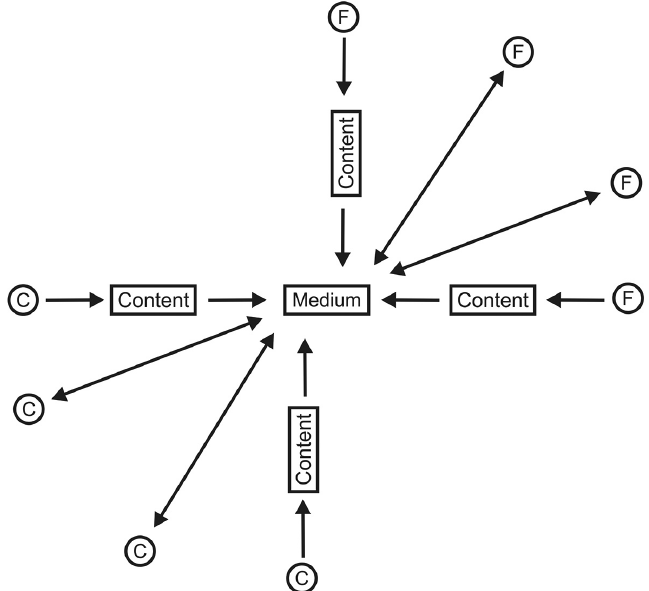
Figure 3. Model of marketing communications in a hypermedia computer-mediated environments (source: Hoffman & Novak,